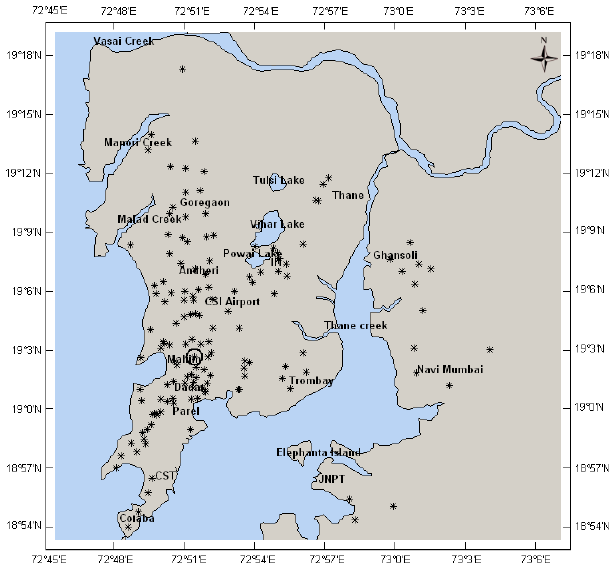
Fig. 1. Map of Mumbai city showing the borehole locations selected for liquefaction